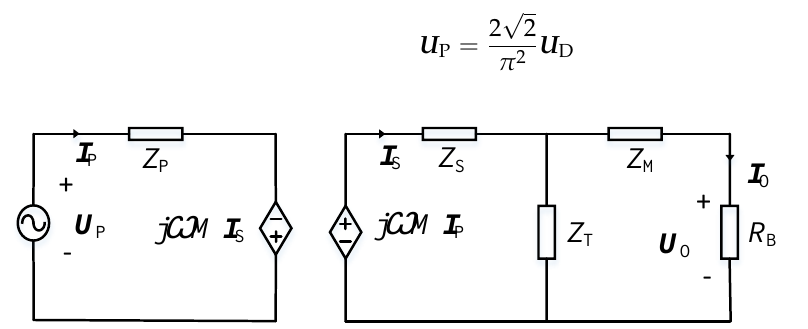
Figure 2. Circuit diagram of the S/PS−compensated WPT System. Figure 3. Equivalent circuit of the S/PS−compensated WPT System.